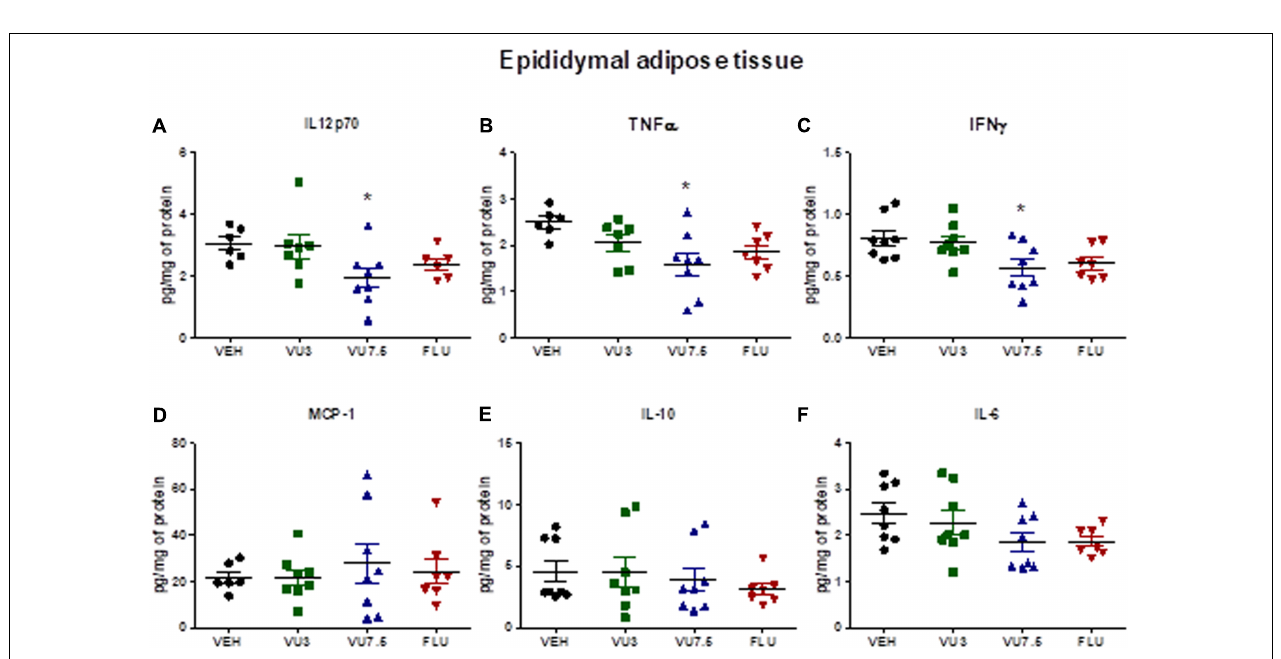
FIGURE 3 | Decreased levels of inflammatory cytokines IL-12p70, TNF- α , and IFN- γ in the epididymal adipose tissue of HFD mice after treatment with VU0409106. Fourteen days’ treatment with VU0409106 7.5 mg/kg of HFD mice reduced (A) IL-12p70, (B) TNF- α , and (C) IFN- γ levels in the epididymal adipose tissue of HFD mice. (D–F) No effect of VU0409106 or fluoxetine on (D) MCP-1, (E) IL-10, or (F) IL-6 levels. The results are shown as mean ± SD from ( n = 6–8). * p < 0.05 compared to vehicle after Bonferroni multiple-comparison post hoc test.